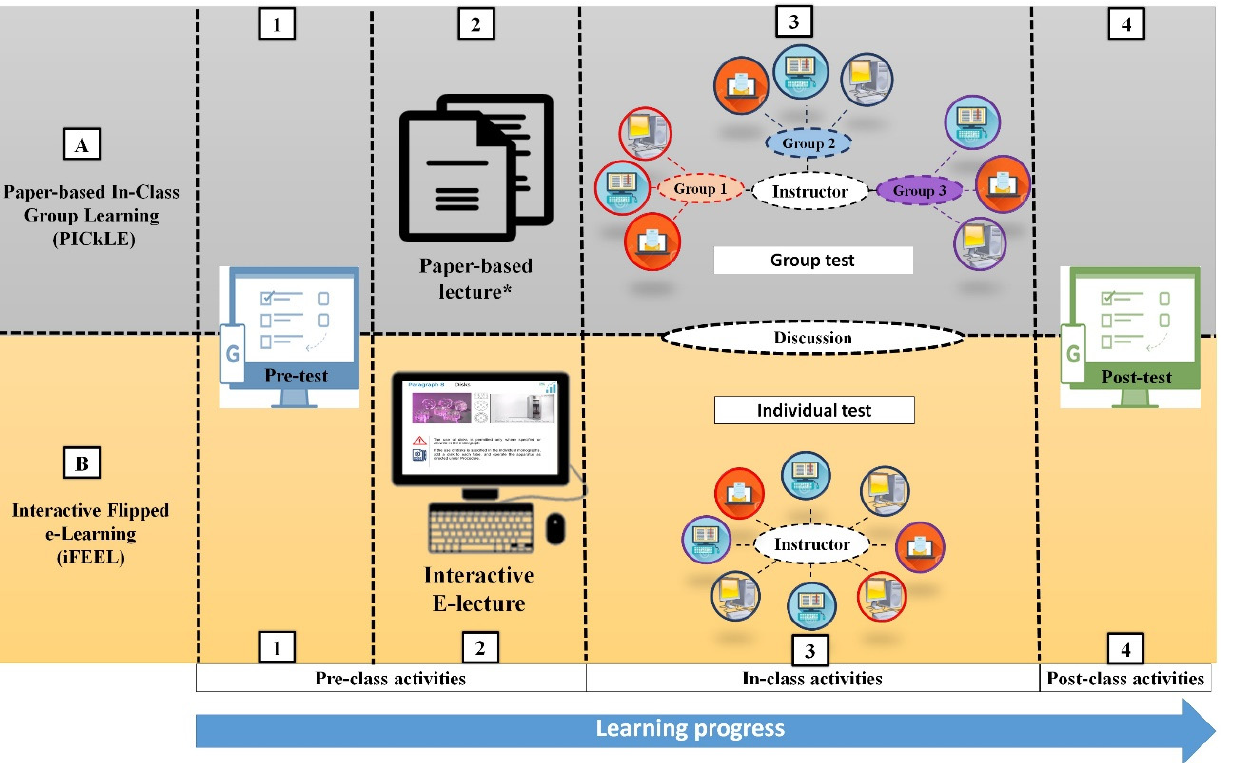
Figure 1. Graphical representation of the execution steps of ( A ) PICkLE and ( B ) iFEEL activities. * The students were informed that the lecture material was intended to be studied during the virtual classroom.